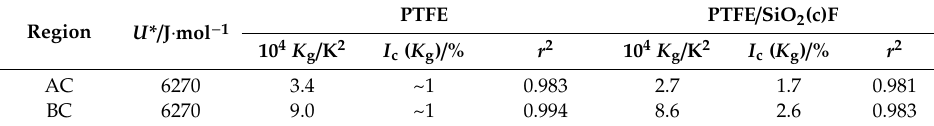
Table 1. Estimation of K g parameter for PTFE and PTFE / SiO 2 (c)F.